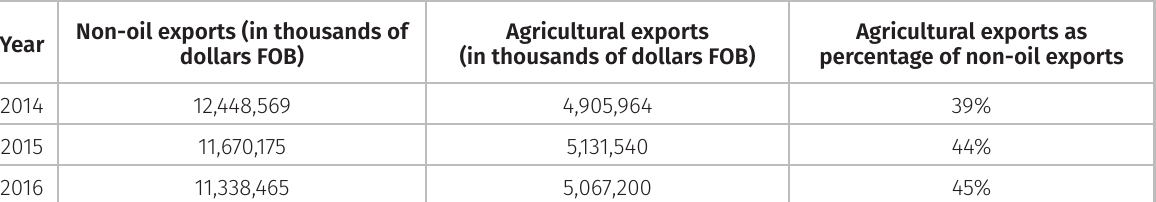
Table II. Evolution of Ecuadorian agricultural exports compared with Ecuadorian non-oil exports between 2014 and 2016 (as percentage of FOB value).